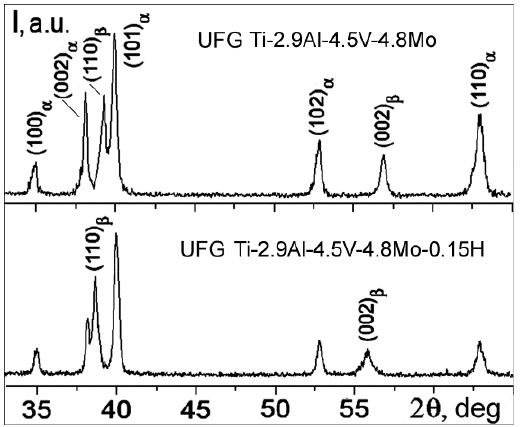
Figure 4. Diffraction patterns of the UFG titanium alloys.